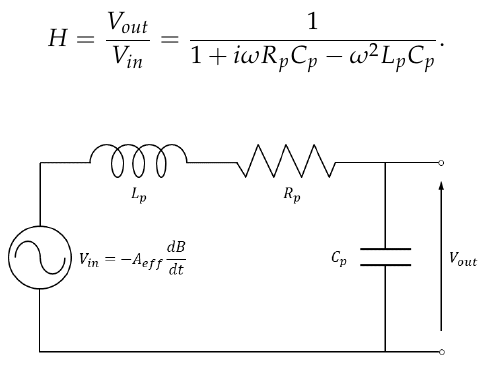
Figure 2. Equivalent circuit of induction sensor with coil self-inductance L p , resistance R p and capacitance C p .